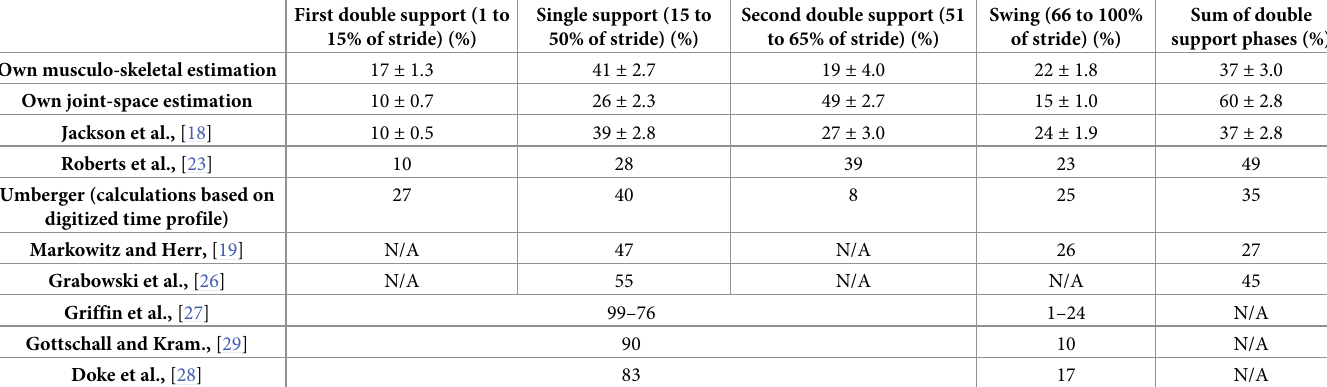
Table 3. Estimated metabolic rate (% mean ± s.e.m.) of different phases of the gait cycle during level walking from the current work and other studies. We seg- mented the strides into double support phases, single support phase, and swing phase based on our ground reaction force data from both legs. Strides are segmented from the ipsilateral heel strike to the next ipsilateral heel strike such that the first double support phase starts with an ipsilateral heel strike and ends with contralateral toe-off, and the second double support phase starts with contralateral heel strike and ends with ipsilateral toe-off. The metabolic rate time profile in the normal walking condition from the Jackson et al., [18] study was obtained by applying the modified Umberger [20] estimation code from [68]. The data from Roberts et al., [23] were obtained from their supplementary data file for walking at 70% of the preferred walking speed. We selected this trial from their supplementary data because the walking speed is most sim- ilar to the walking speed from our study (1 m � s -1 ). We obtained the unilateral metabolic rate from the right ankle knee and hip joints by entering the data from the right ankle knee and hip as inputs to their MATLAB code and entering signals with zeros for all non-lower limb joints and all joints on the left side of the